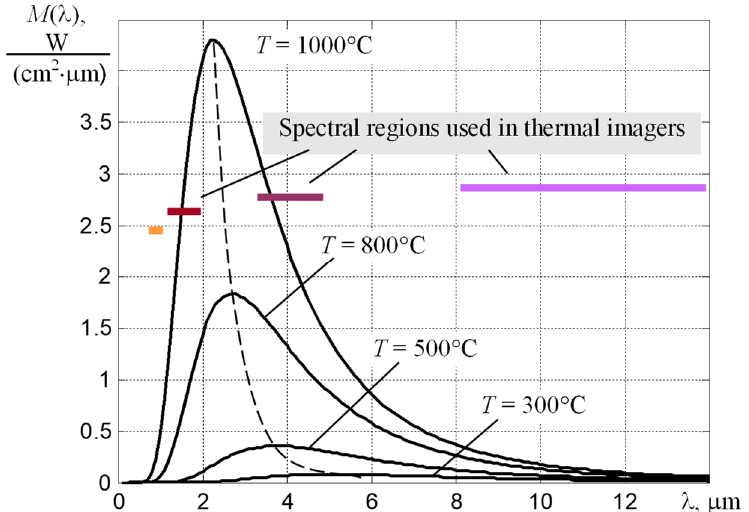
Figure 1. Dependences of the spectral density of the surface luminosity of the absolute black body on the wavelength at different temperatures and spectral regions that are used in modern thermal imagers of the NIR, SWIR, MWIR, and LWIR spectral ranges.